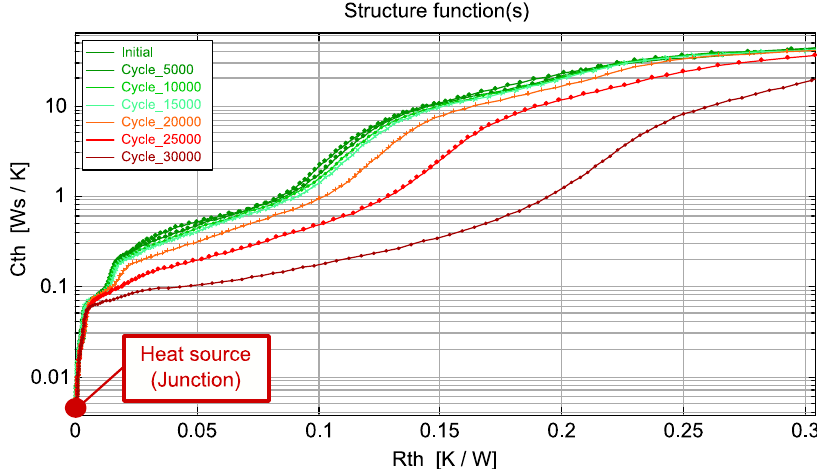
Figure 7. Structure functions of the IGBT sample corresponding to the initial status and to the control measurements captured during the test.